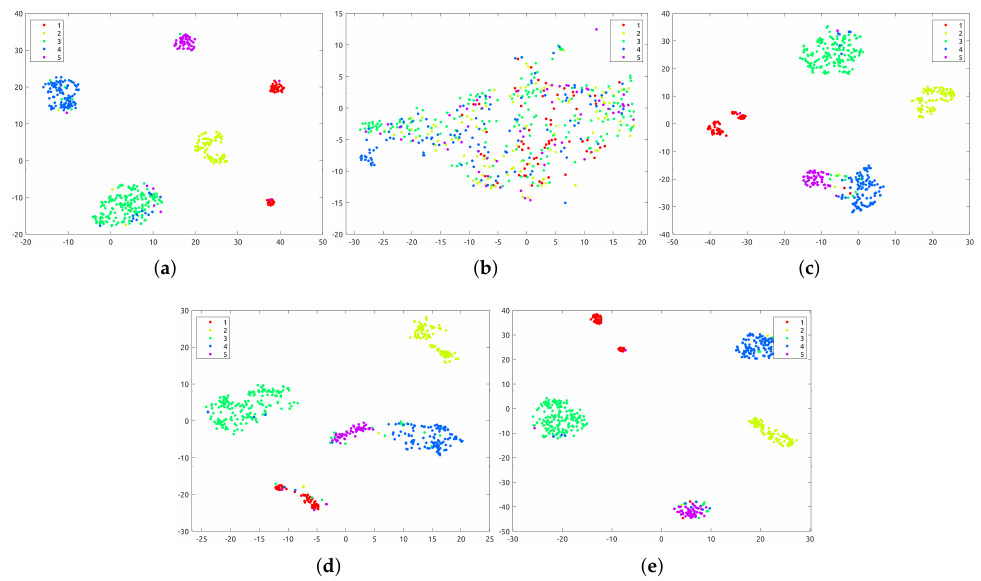
Figure 3. Visualization of the clustering results of the first 5 classes of BBCSport with t-SNE. ( a ) MLAN. ( b ) MCGC. ( c ) GMC. ( d ) CGL. ( e )